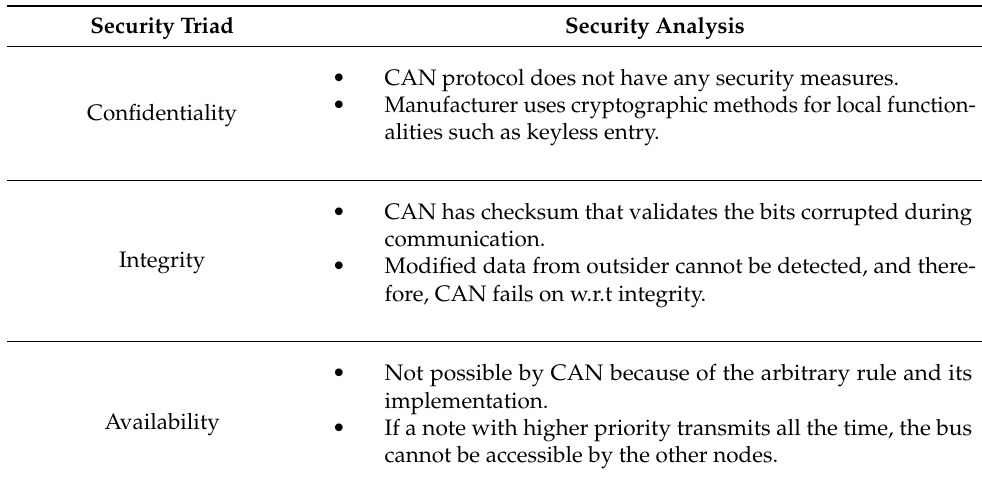
Table 2. CIA security model analysis of CAN protocol.